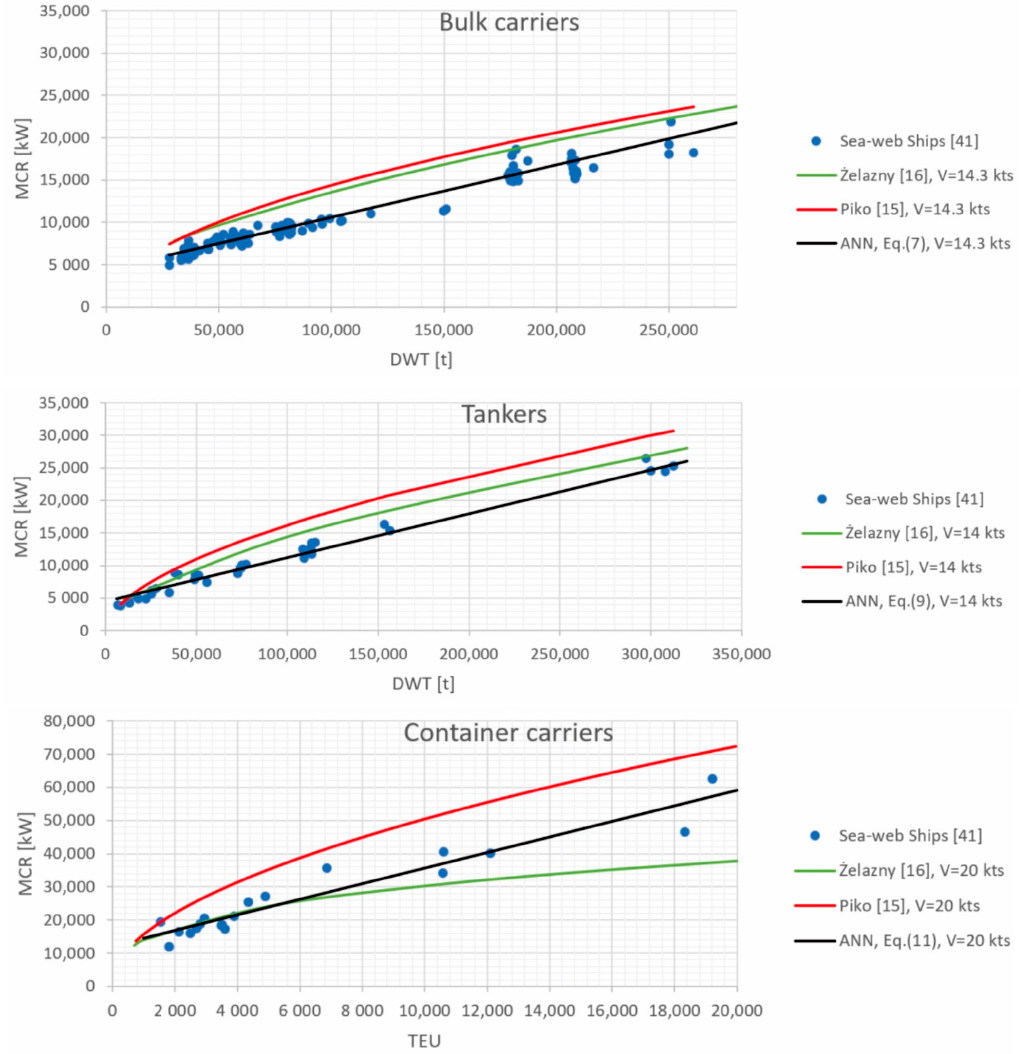
Figure 16. Total engine power MCR in the function of DWT or TEU capacity at constant average speed for a given ship type.